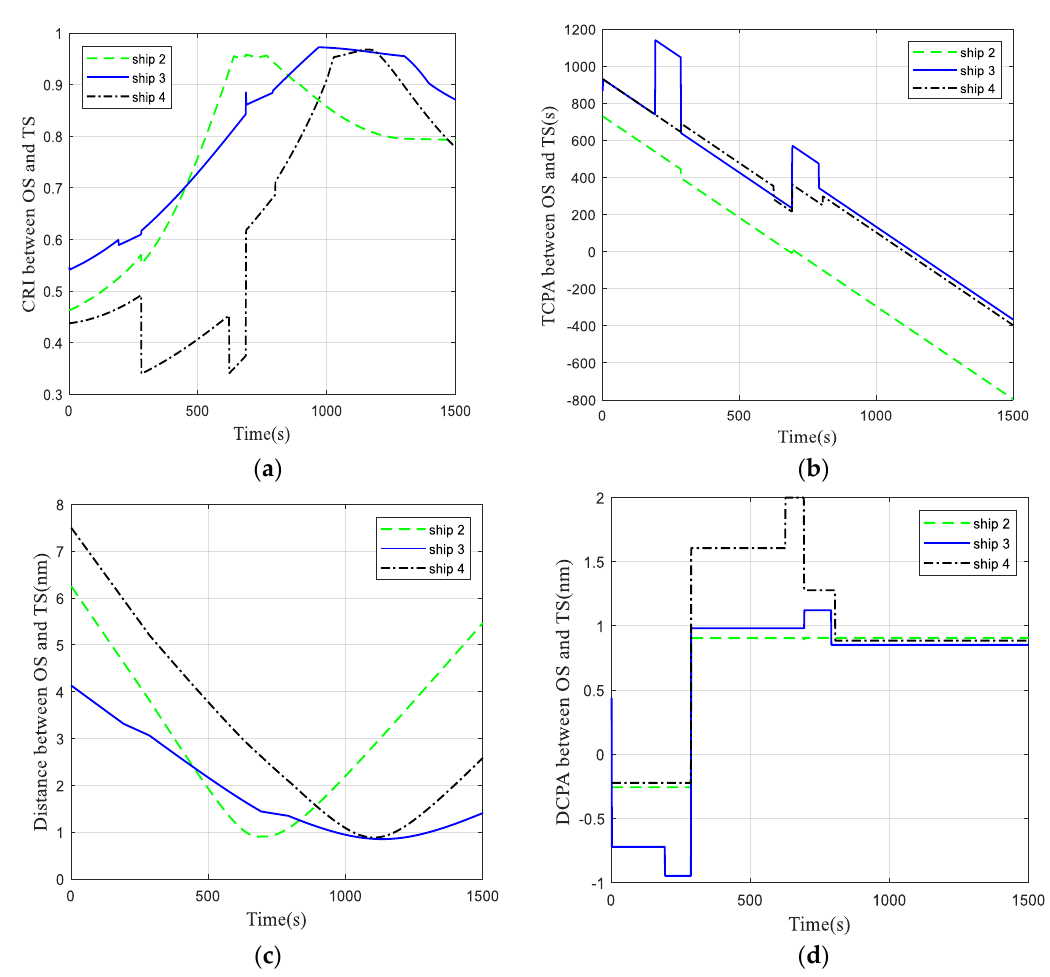
Figure 6. Real-time parameter changes under scenario 1: ( a ) the collision risk index ( CRI ) with the Target Ships (TSs), ( b ) the time to the closest point of approach ( TCPA ) with the TSs, ( c ) the relative distance with the TSs and ( d ) the distance to the closest point of approach ( DCPA ) with the TSs.